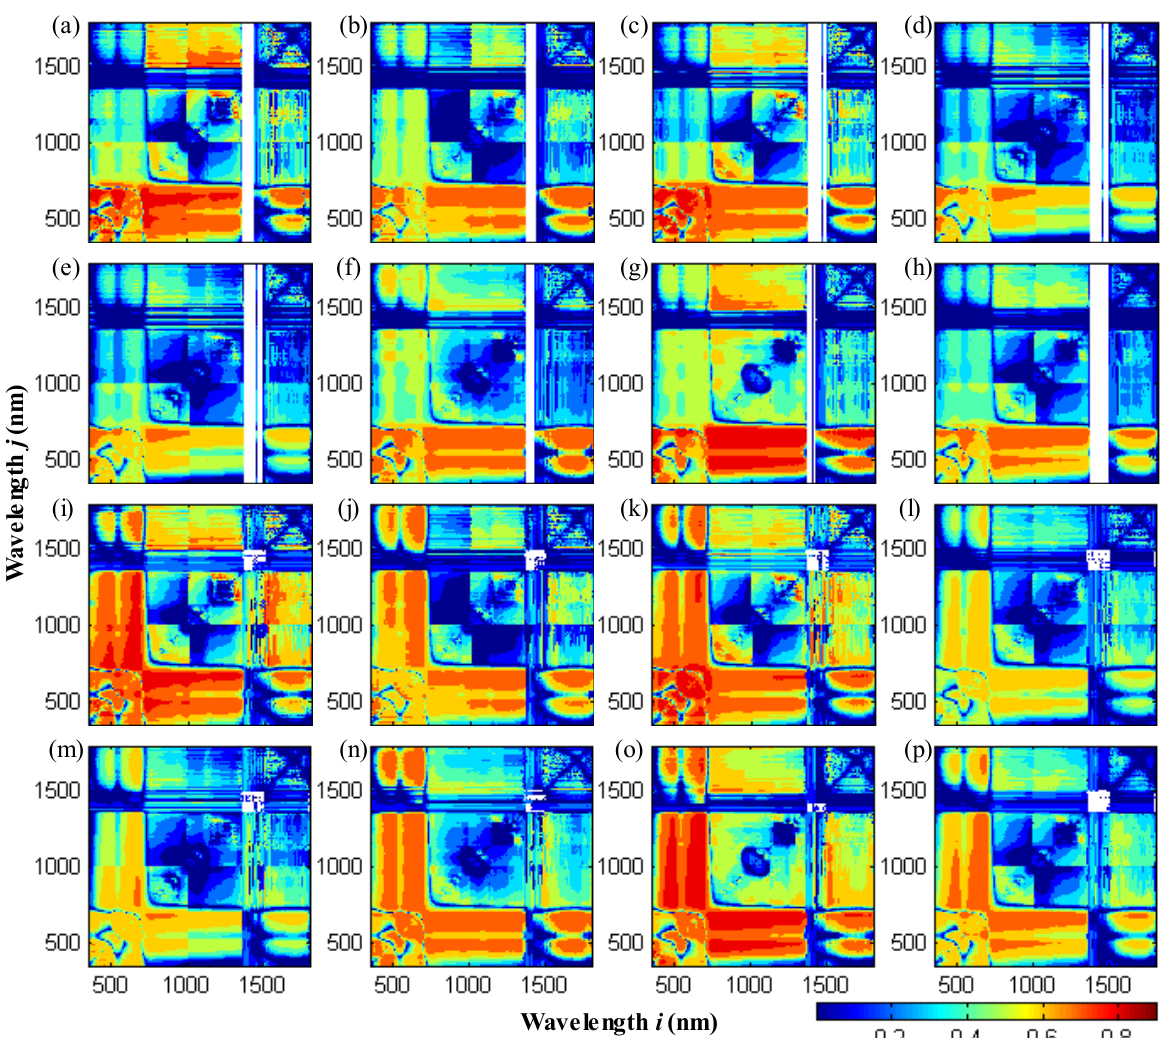
Fig. 1. Contour maps showing the values of R 2 for the relationships between LCC and SRs (a-h) and NDVIs (i-p) composed of random two-bands combinations throughout the range of 350 to 1800 nm across all growth stages for each single variety (a-g/